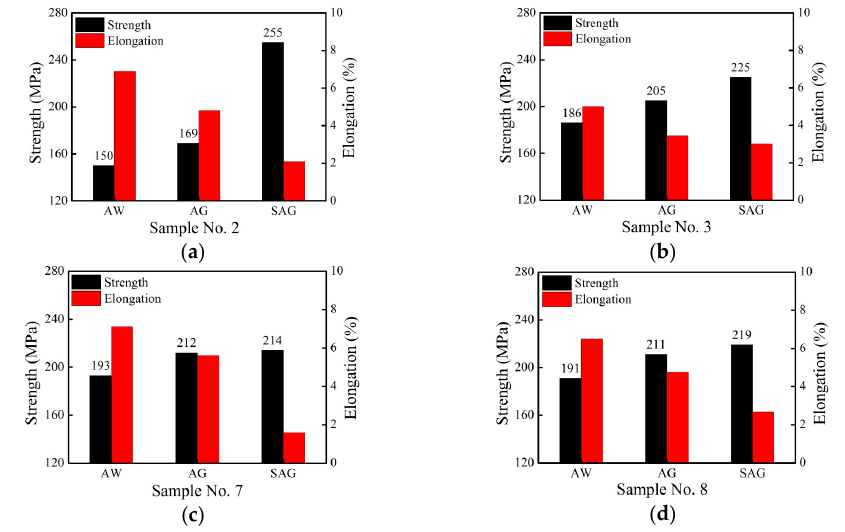
Figure 10. Effect of different PWHTs on the mechanical properties of welded joints: ( a ) sample No. 2; ( b ) sample No. 3; ( c ) sample No. 7; and, ( d ) sample No. 8. ( b ) sample No. 3; ( c ) sample No. 7; and ( d ) sample No.